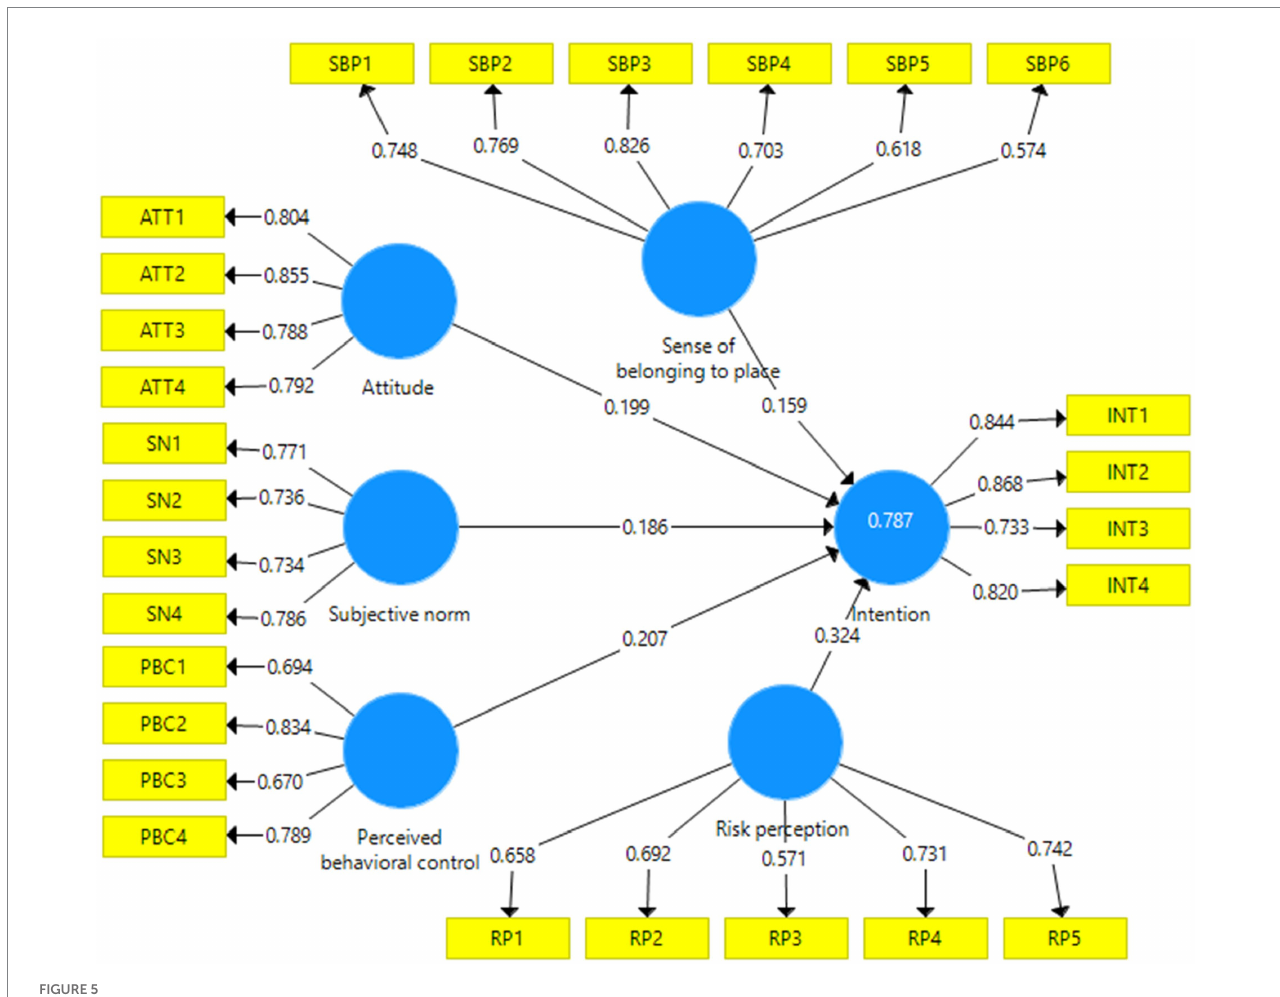
FIGURE 5 Extended TPB structural model with standardized path coefficients.